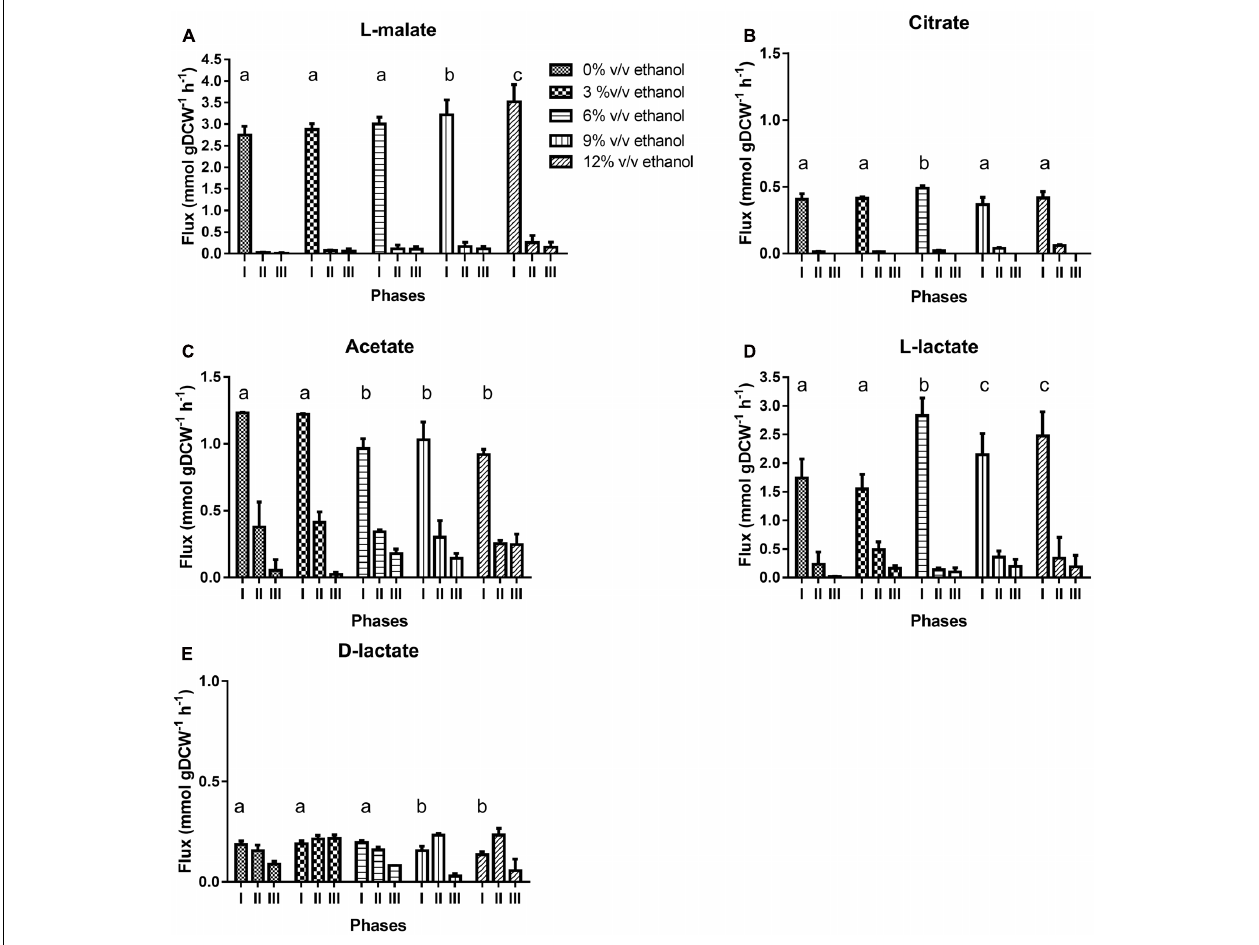
FIGURE 4 | Specific consumption of L -malate (A) and citrate (B) and specific production of acetate (C) L -lactate (D) and D -lactate (E) during growth of O. oeni PSU-1, under increasing ethanol contents. Statistical analysis only was performed in phase I and shared letters indicate no significant difference (Mood test, p <